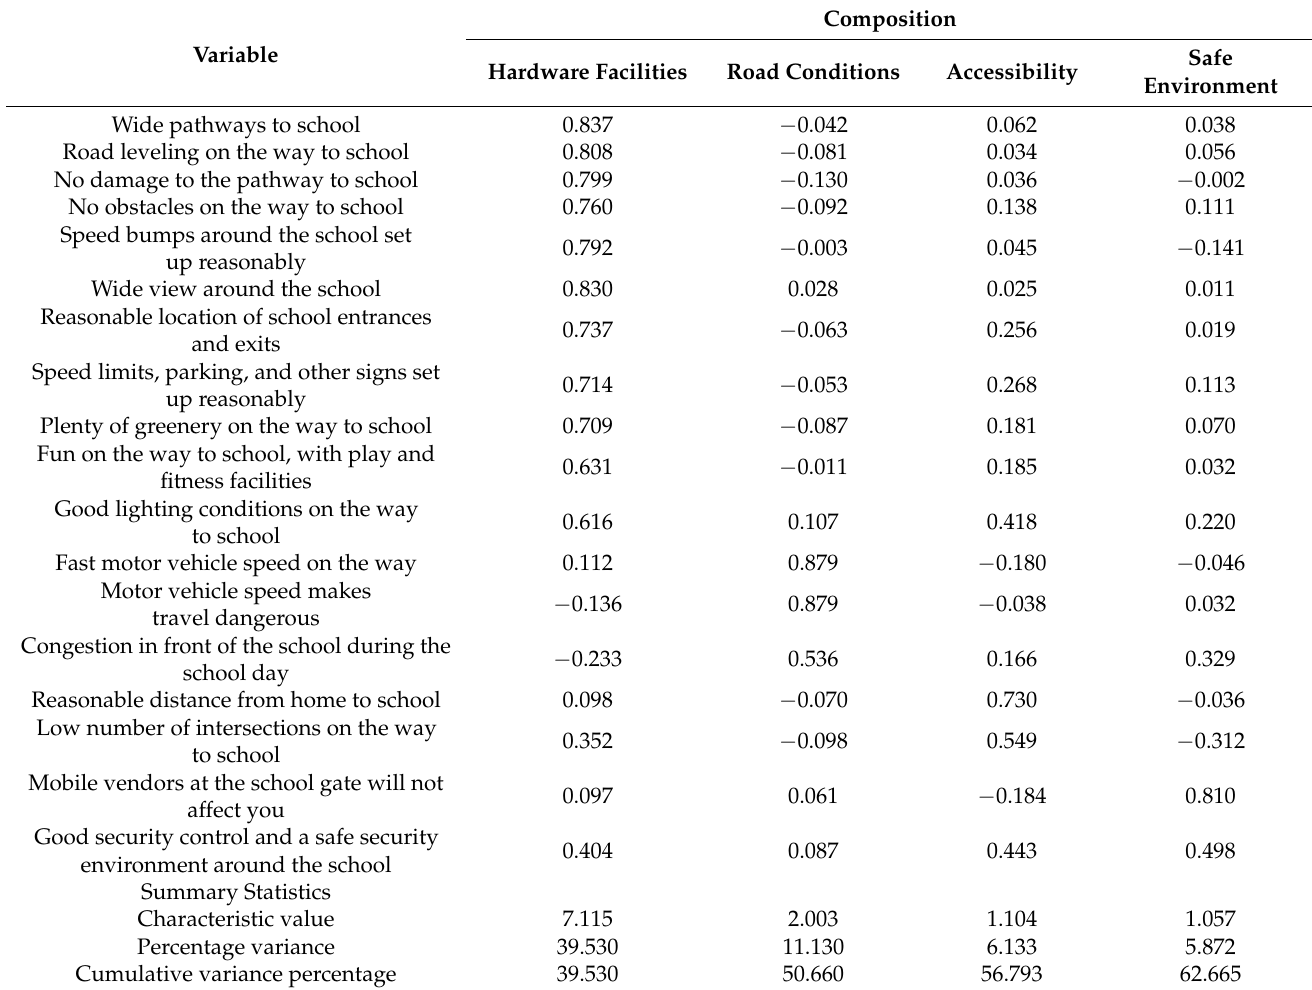
Table 3. Component matrix of school travel built environment